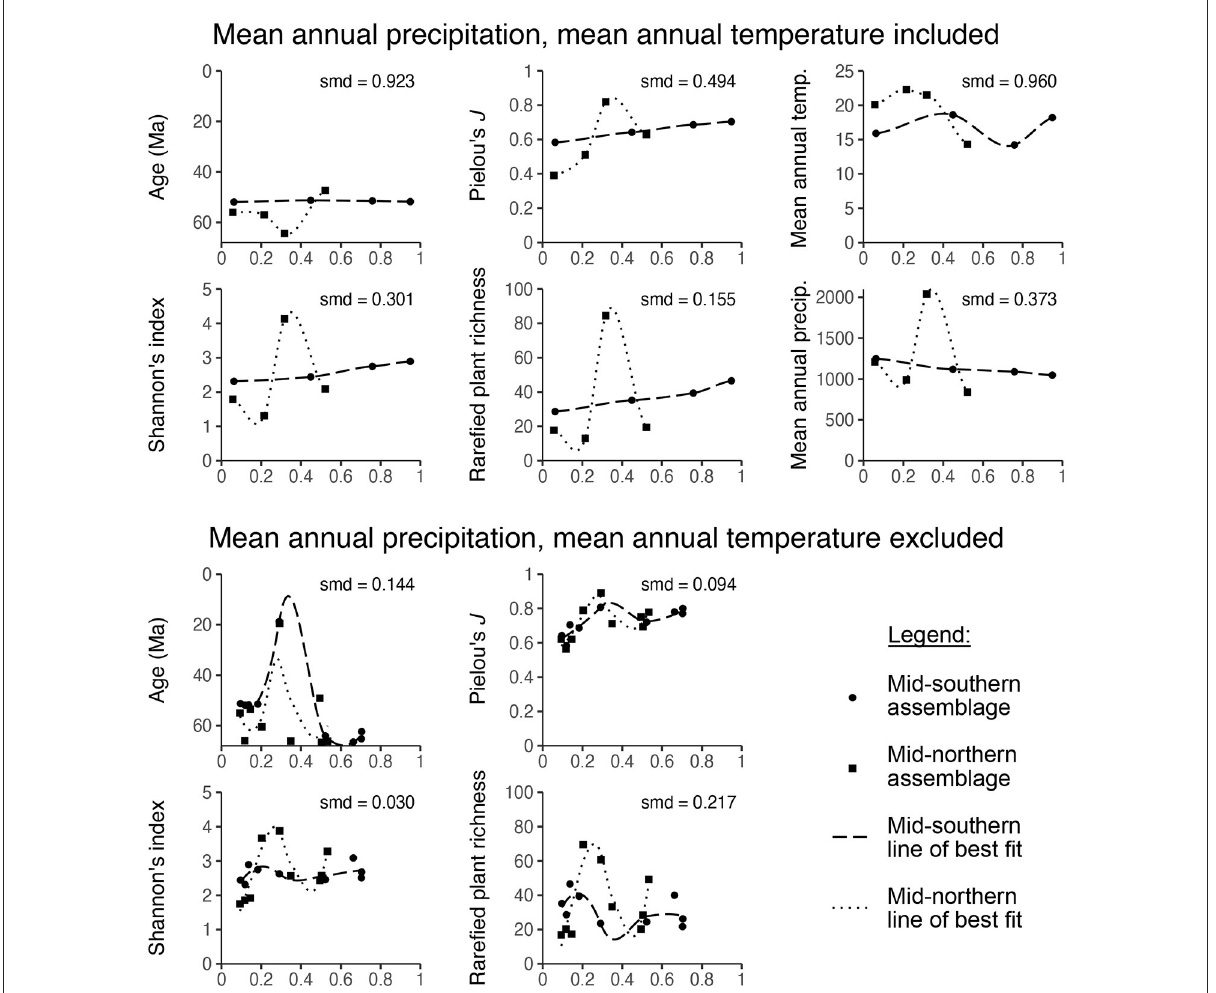
FIGURE7 The relationship between propensity score and various covariates for Currano et al. (2021)’s mid-northern and mid-southern latitudinal bins with loess smoothed lines of best fit. The standardized mean difference (smd) among the two latitudinal bins is listed for each